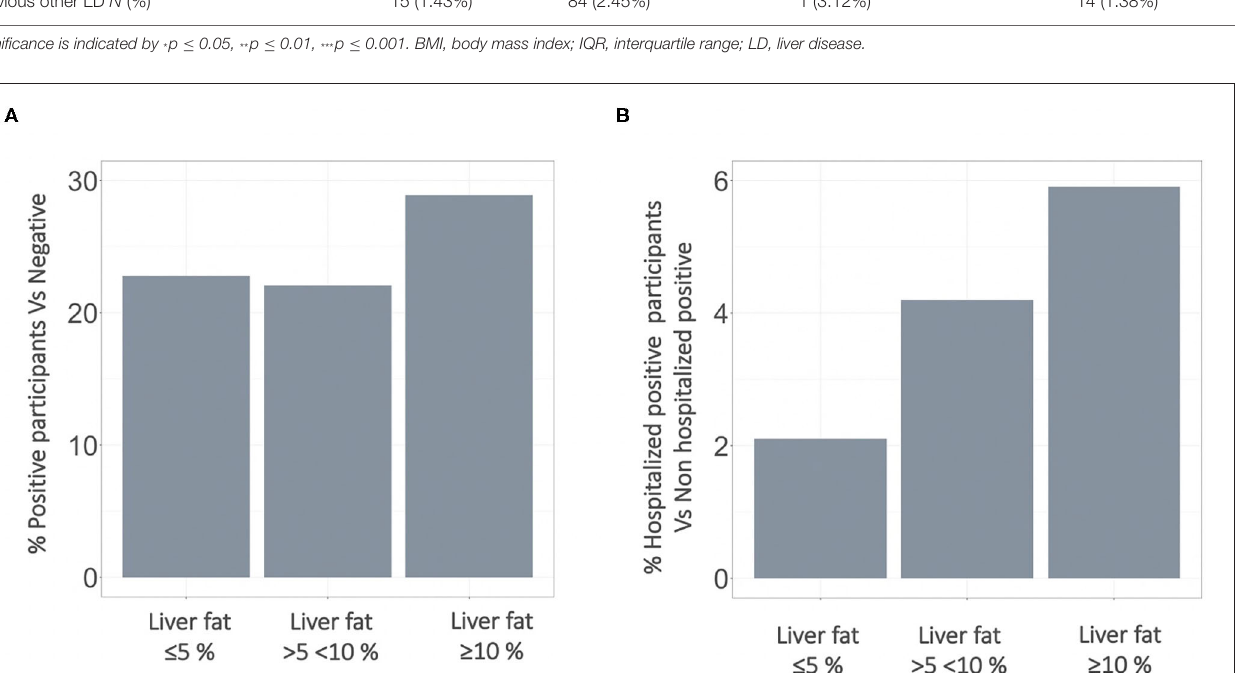
test, and difference in the counts of the binary outcomes were compared using two tailed Fisher’s exact